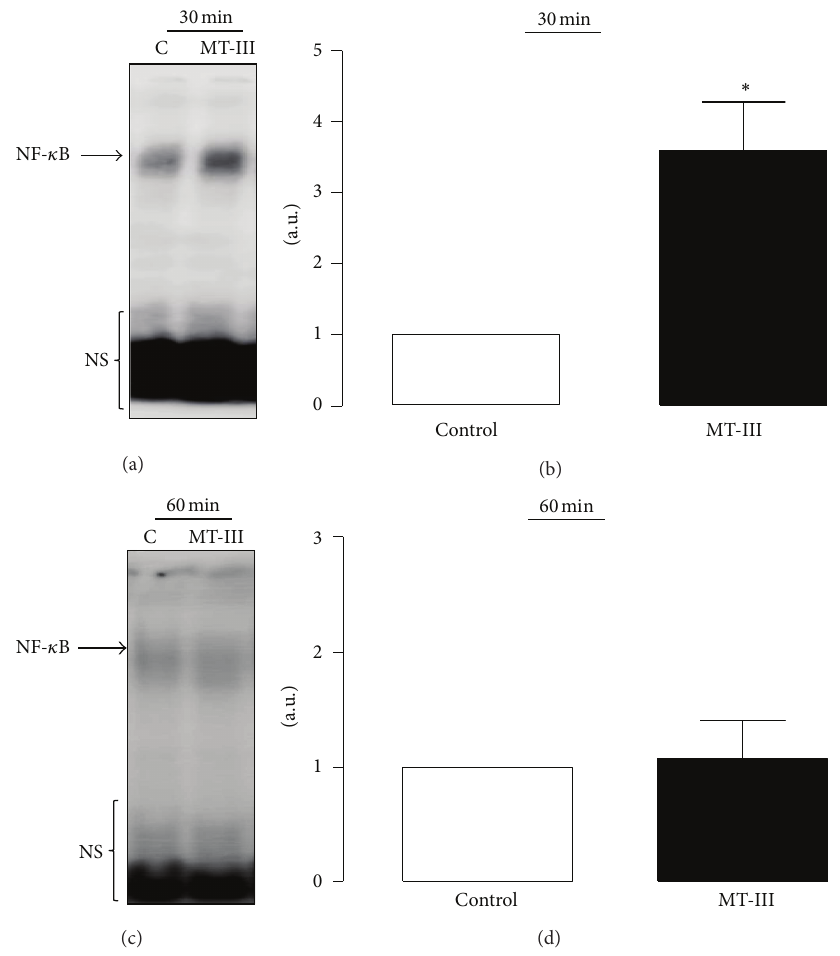
Figure 1: MT-III activates NF- 𝜅 B in macrophages in culture. (a, c) Macrophages nuclear extracts were prepared and assayed for 𝜅 B probe activity with 32 P-labeled double-stranded oligonucleotide 𝜅 B by EMSA. (b, d) Densitometric analysis of NF- 𝜅 B band intensities. Results are expressed as mean ± SEM from three experiments. ∗ 𝑃 < 0.05 as compared with control value. NS: nonspecific band; C: control; NC: negative